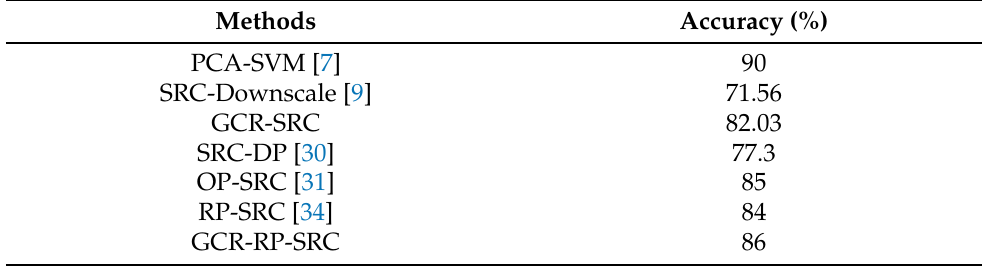
Table 4. Comparison between proposed and other FR methods on Yale